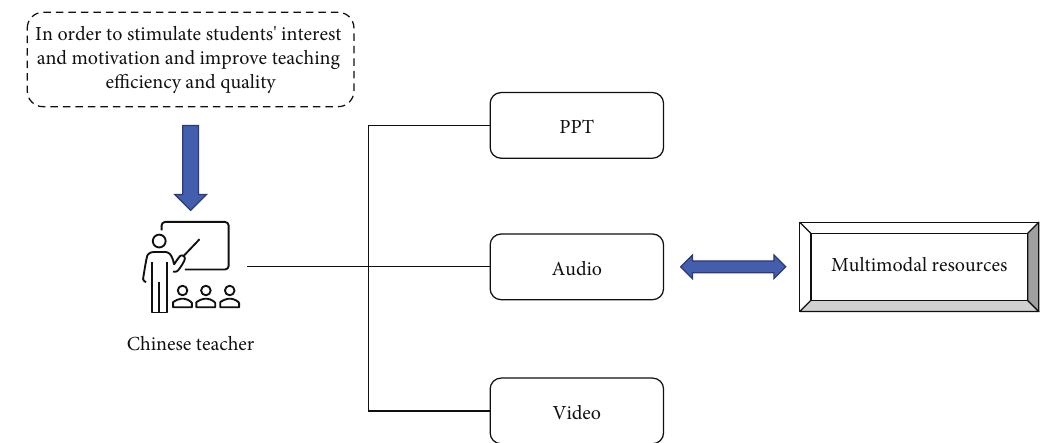
Figure 2: Teaching model of Chinese